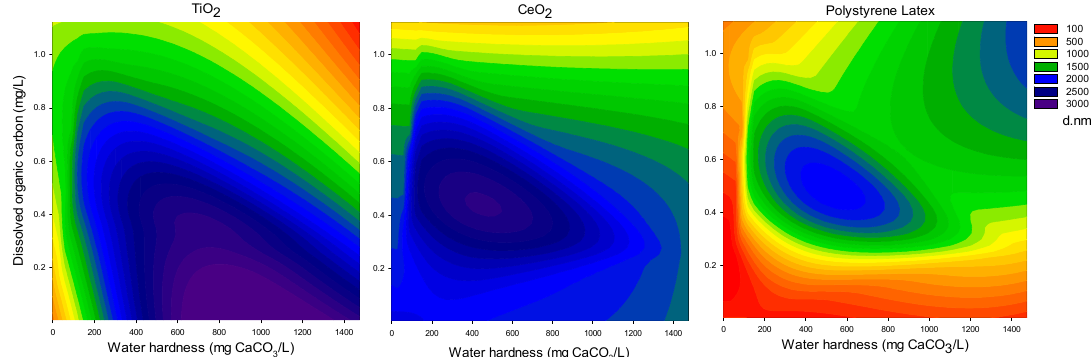
Figure 11. Aggregation intensity diagrams of TiO 2 , CeO 2 , and amidine PS nanoplastic particles as a function of water hardness and Dissolved Organic Carbon (DOC) in MW and SW at a 10 mg / L TiO 2 , CeO 2 and PS nanoplastic concentration. The color and respective values in the legend represent the z-average diameter of NPs and PS nanoplastic particles in nanometers that were obtained after 1h. Blue color indicates significant aggregation, whereas red color indicates limited aggregation.